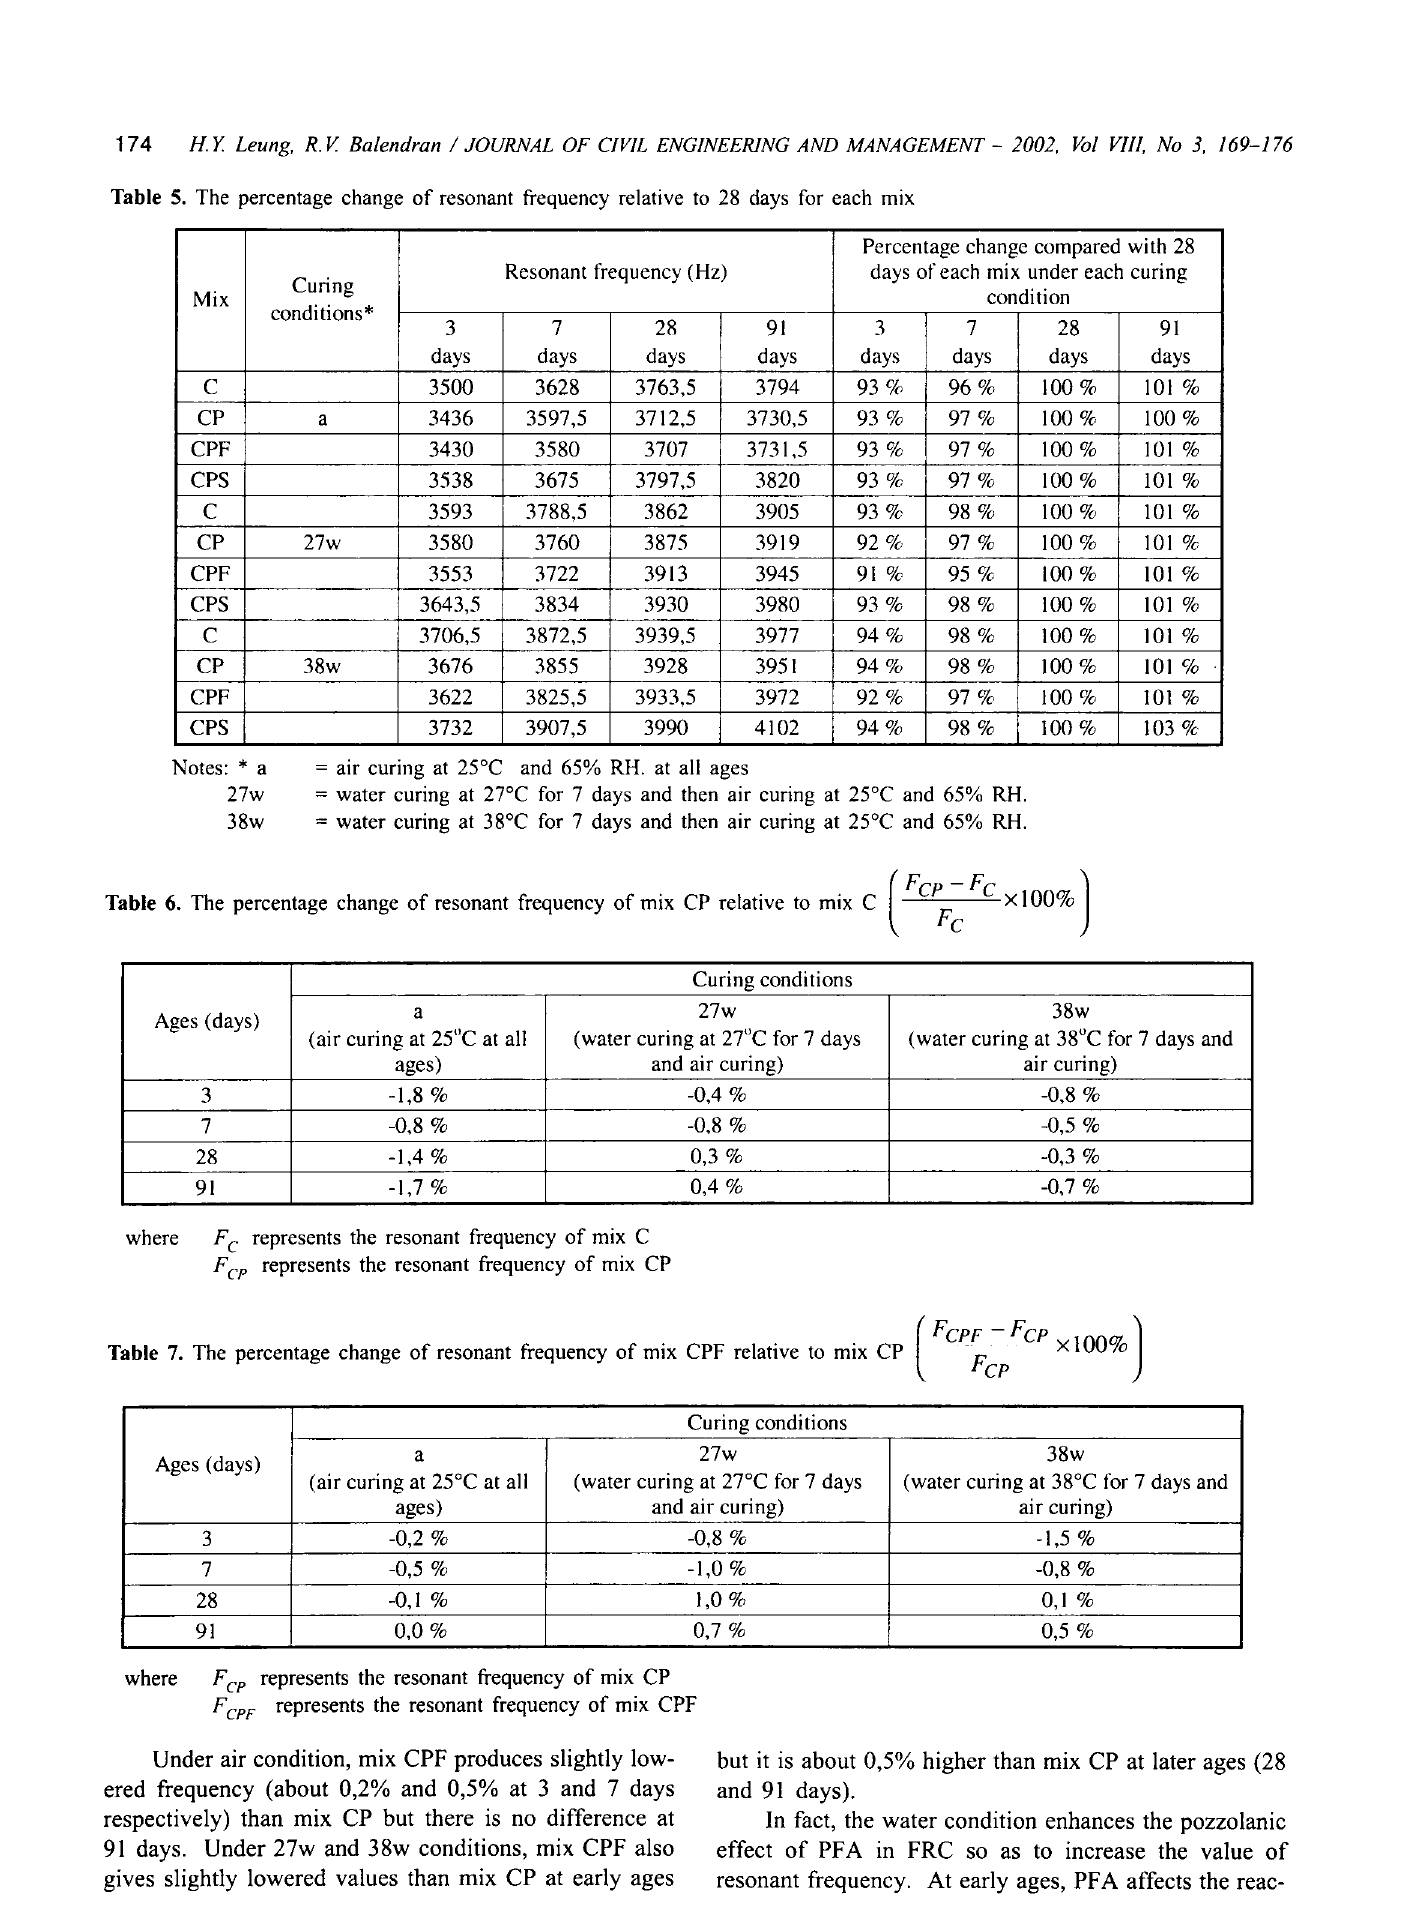
Table 5. The percentage change of resonant frequency relative to 28 days for each mix Percentage change compared with 28 Resonant frequency (Hz) days of each mix under each curing Curing